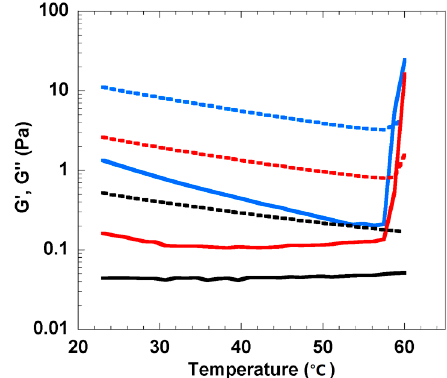
Figure 1. Storage modulus, G’, (solid lines) and loss modulus, G’’, (dashed lines) as functions of temperature for 2 wt% (black), 3 wt% (red) and 4 wt% (blue) cellulose solutions. The temperature ramp was performed with a heating rate of 1 °C/min at a constant frequency of 1 Hz and strain amplitude of 10%.